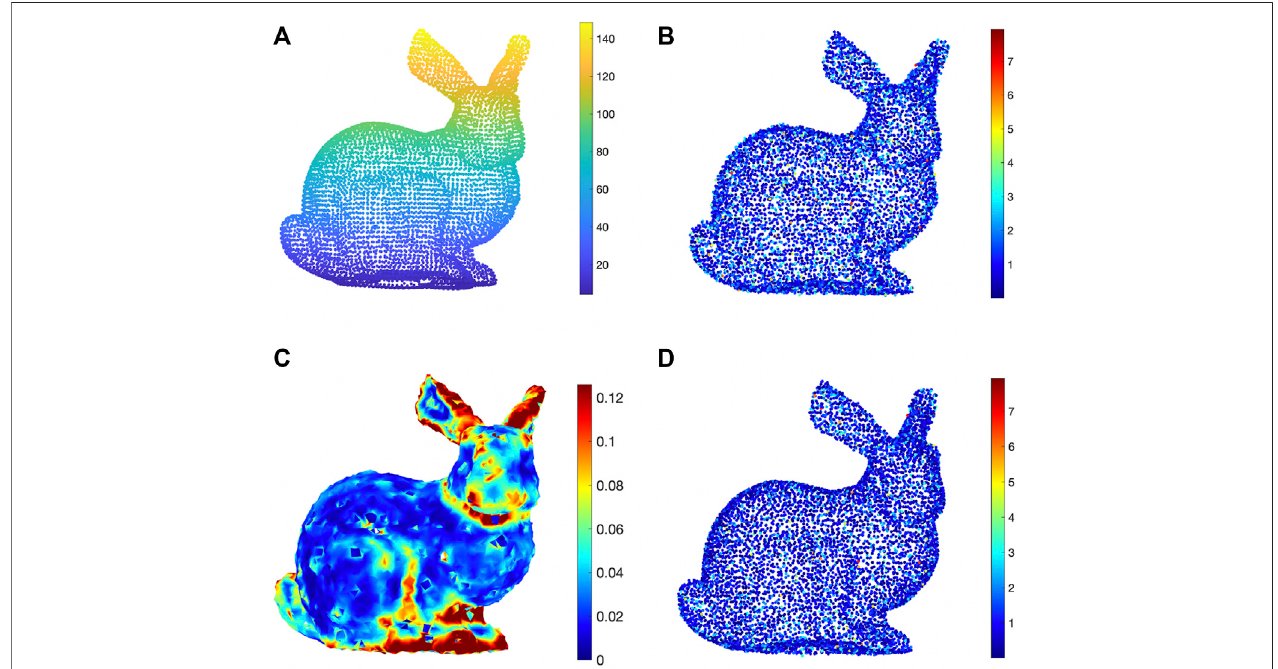
FIGURE 11 | Results of VIPDA at each step. We consider a point cloud related to the Stanford bunny (Turk and Levoy 1994) which is represented with its original coordinates p i in panel (A) . Then, a Gaussian noise w i is added with SNR = 38, and the noisy points q i on the point cloud are represented in panel (B) . The colors associatedtothecolorbarcorrespondtothedifferencebetweennoisyand originalcoordinates (cid:3) p